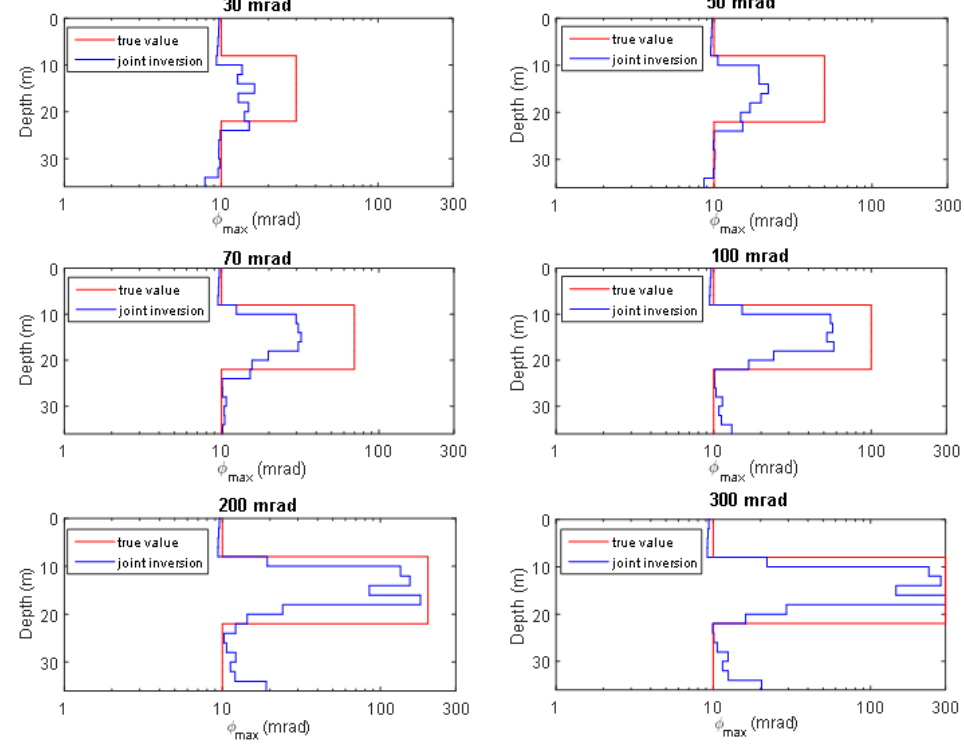
Figure 16. The recovering ability of the joint inversion for different chargeabilities: ϕ max takes 30, 50, 70, 100, 200, and 300 mrad, respectively.